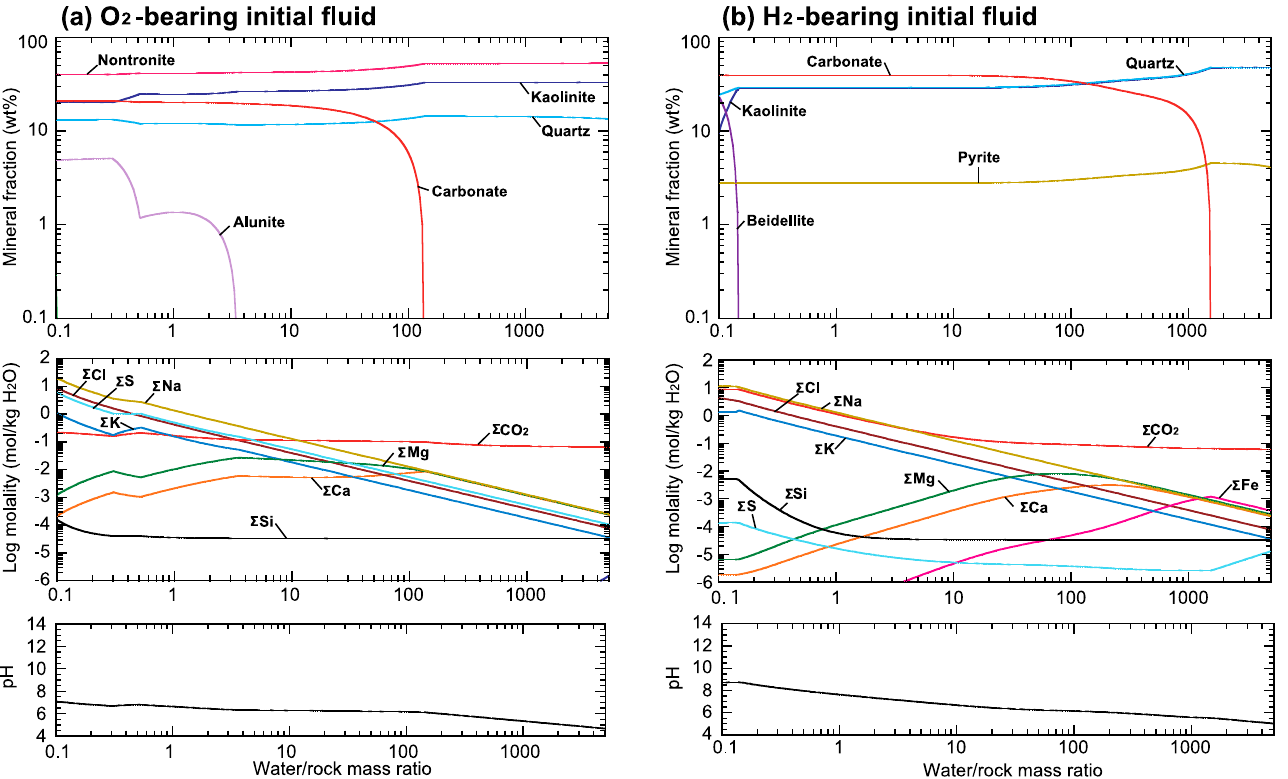
Figure 1. Results of the modeled secondary mineral assemblage and river water chemistry as a function of water-to-rock mass ratio (W/R) at 5 °C ( a ) initial fluid of I-R (O 2 -bearing fluid); ( b ) initial fluid of II-R (H 2 -bearing fluid). Gas fugacities were fixed at values listed in Table 2 during the water–rock reactions.